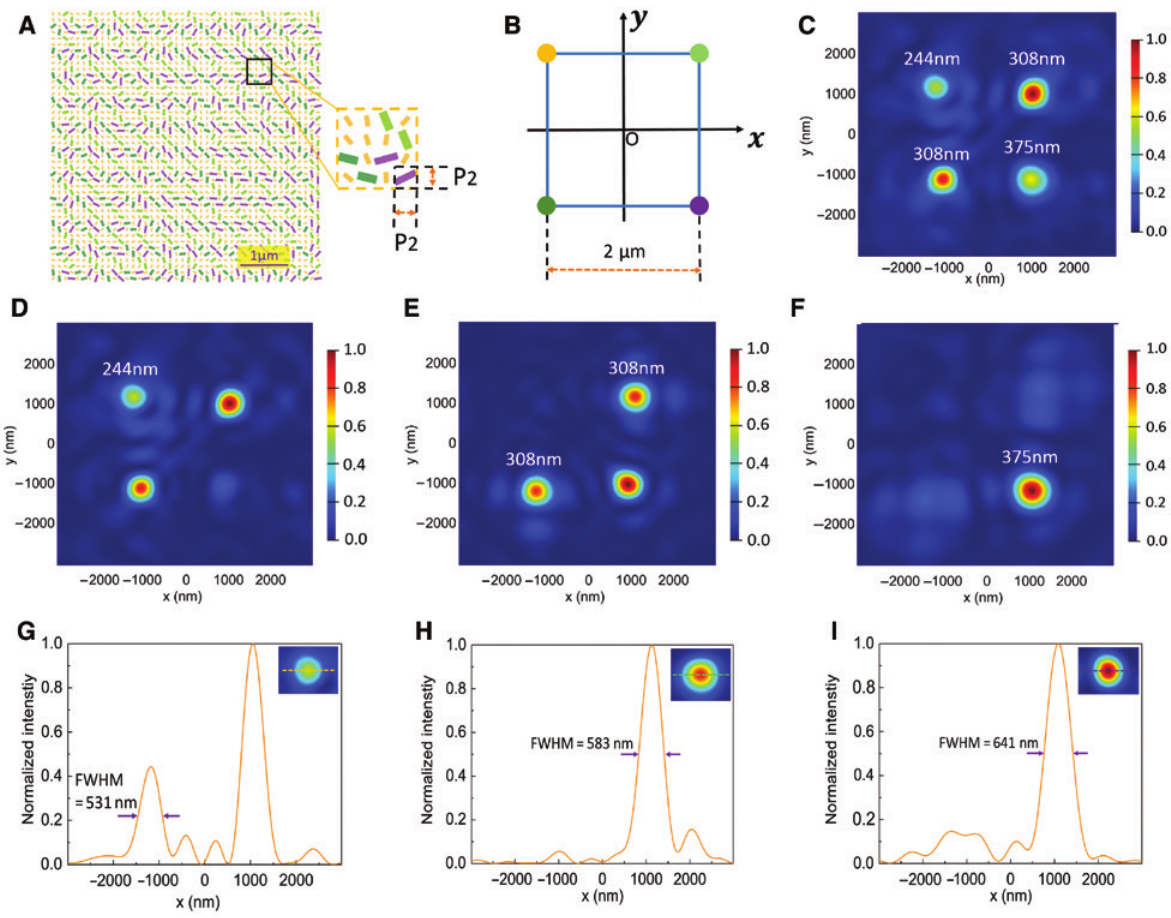
Figure 7: UV router for multiple UV wavelengths at 244, 308 and 375 nm, where the incidences are routed into four positions forming a